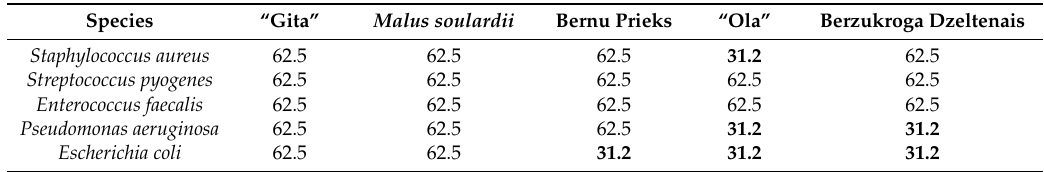
Table 4. Minimal inhibitory concentration values of the five Malus spp. pomace oils against five reference test cultures, mg mL − 1